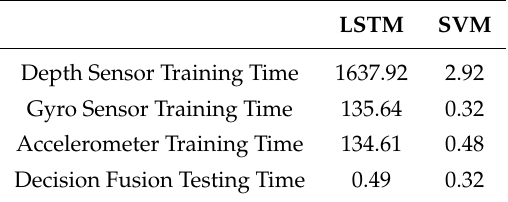
Table 2. Comparison results of computational time